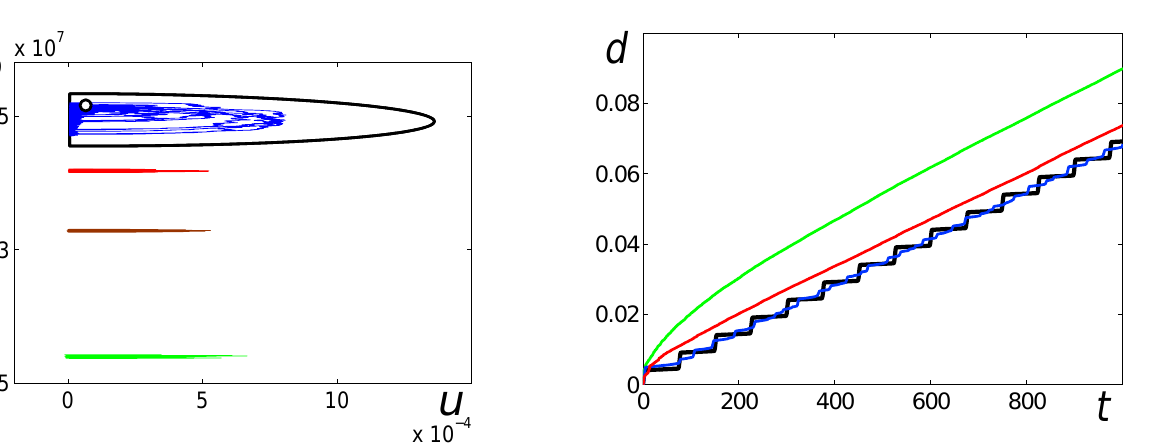
Figure 6. Random trajectories p (Pa) vs. u (ms − 1 ) for ε = 10 − 4 (blue), ε = 5 × 10 − 4 (red), ε = 7 × 10 − 4 (brown), and ε = 10 − 3 (green). The open circle designates the point of unstable equilib- rium.